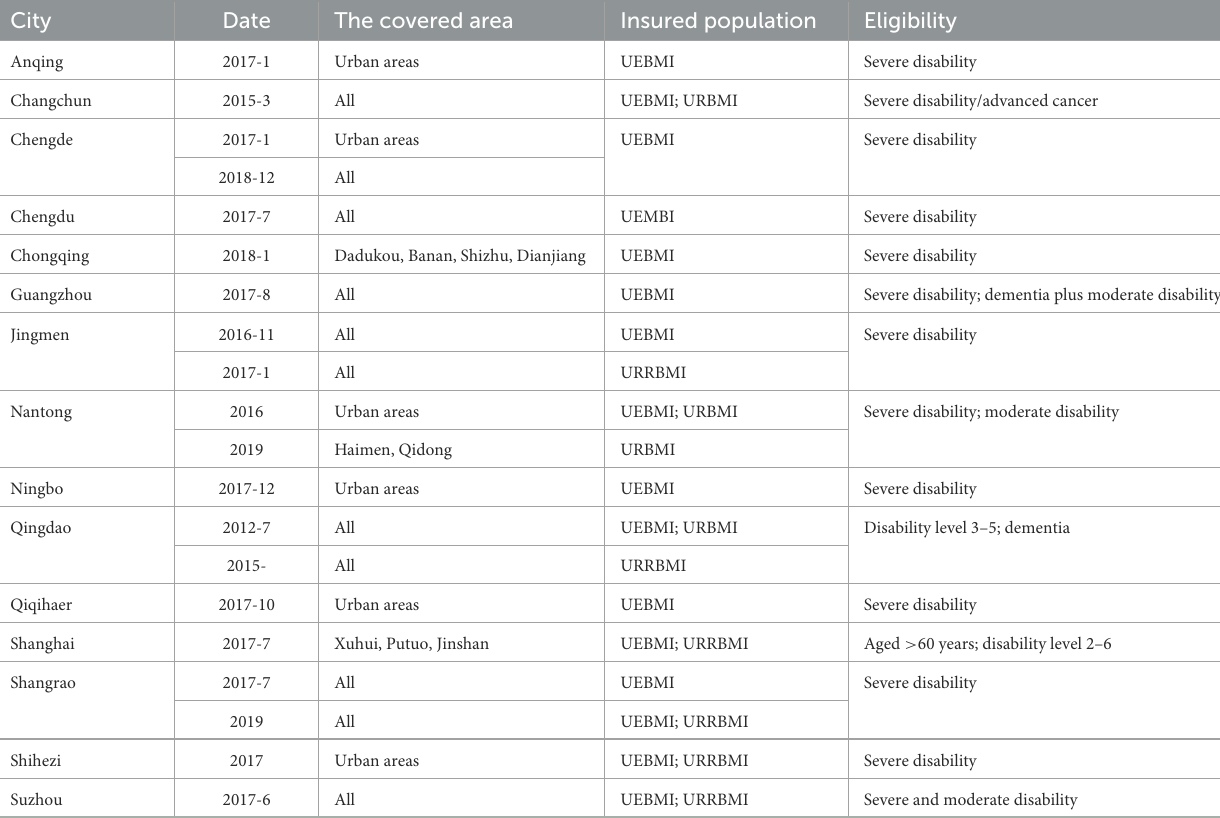
TABLE 1 Key features of 15 pilot cities.